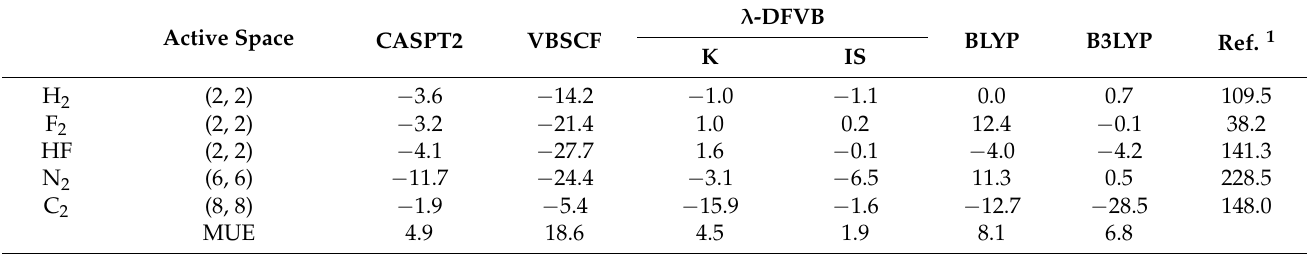
Table 2. Deviation values of the bond dissociation energies ( D e , in kcal/mol) of diatomic molecules. Active